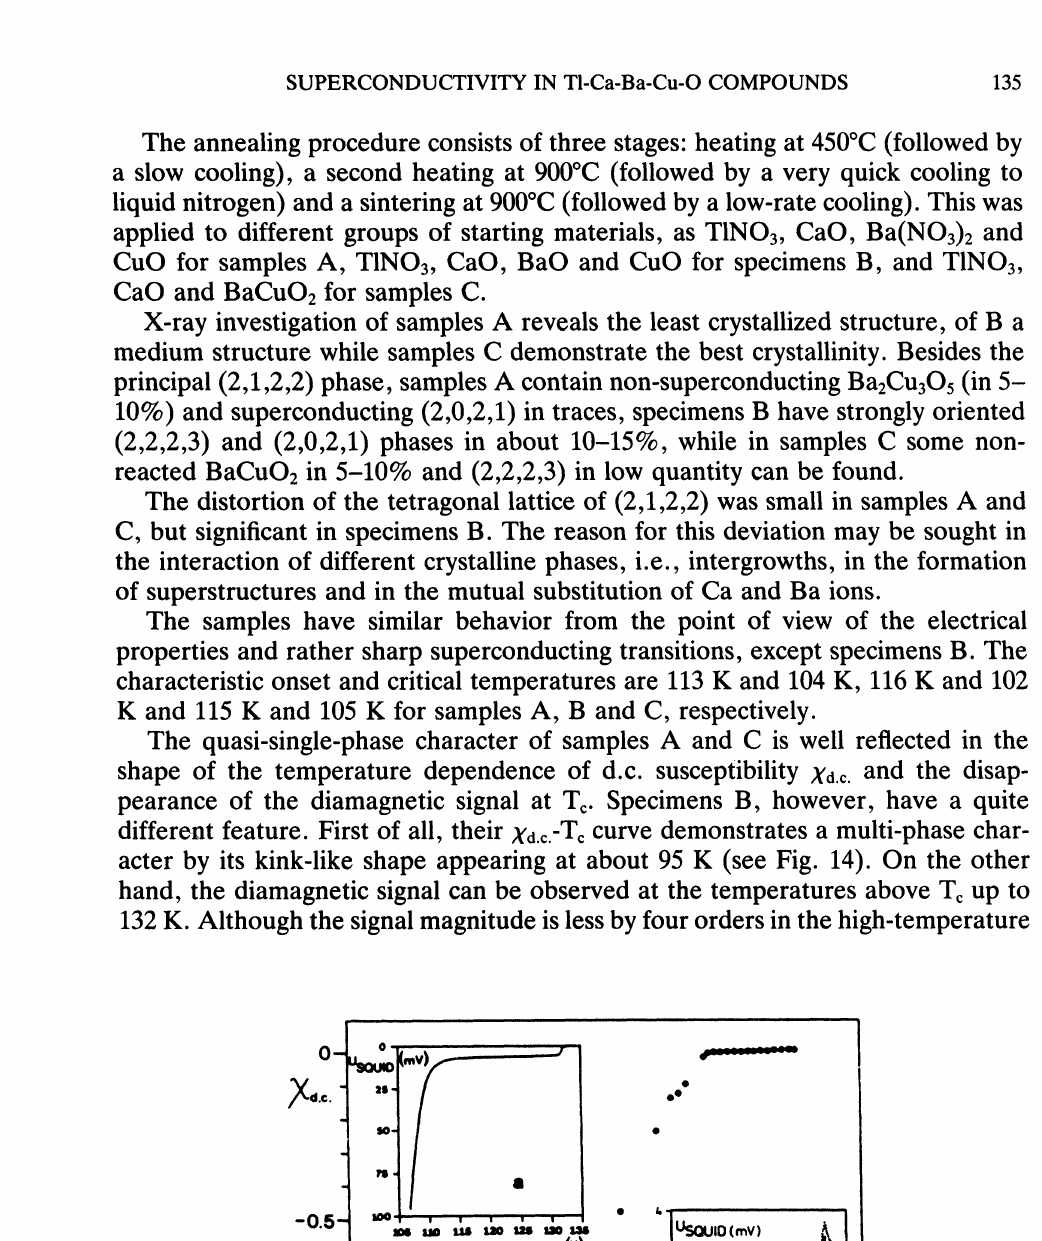
FIGURE 14 Existence of a diamagnetic signal above